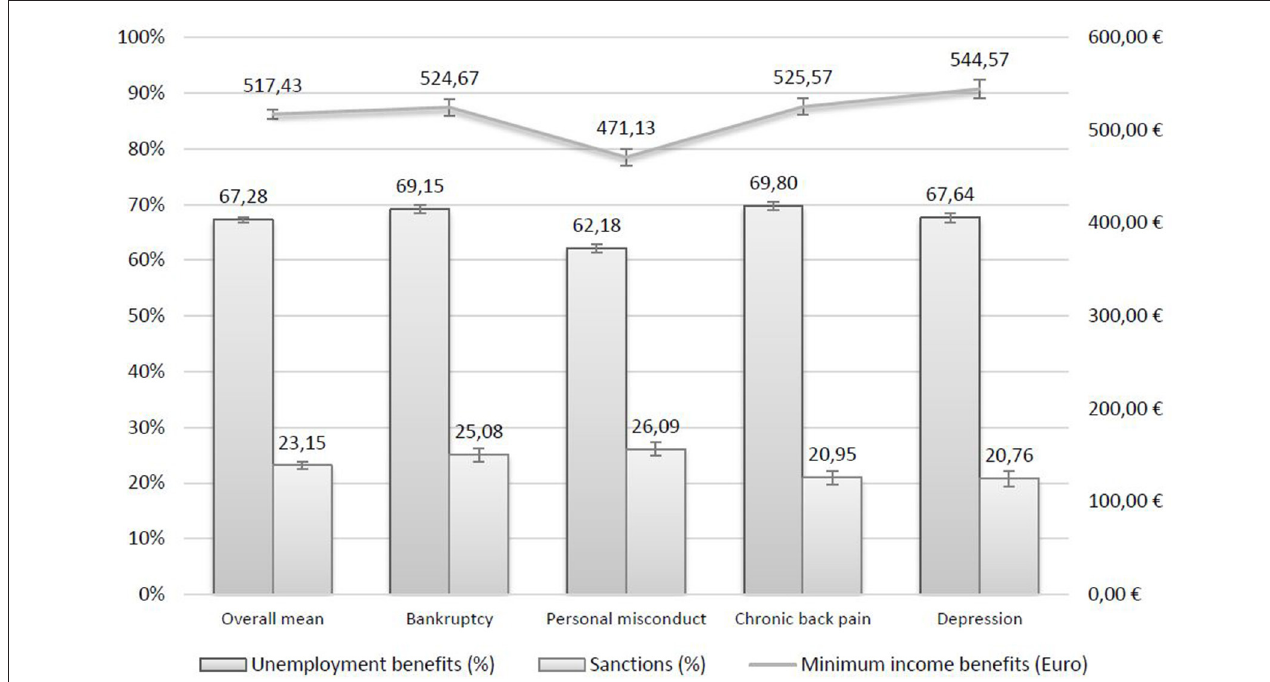
FIGURE 1 | Allocation of unemployment benefits, minimum income benefits and sanctions with 95%-confidence intervals for different reasons of unemployment. Vignette study ( N = 2,621), own weighted sample calculations. Bar heights (in %) and absolute values (in Euro) reflect predicted mean values of corresponding